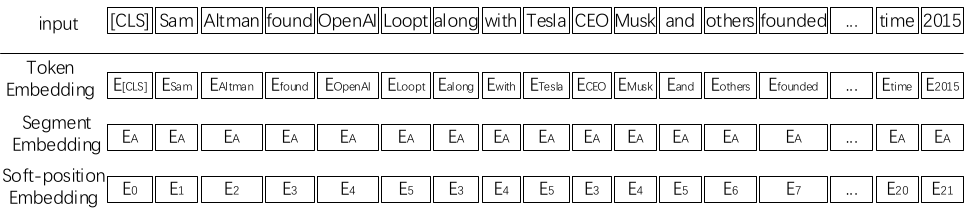
Figure 7. Embedding representation diagram. The process of converting a relation tree into an embedding representation. For the token embedding, the tokens in the relation tree are flattened into a sequence of token embedding by their hard-position index. The soft-position index is used as position embedding along with the token embedding.